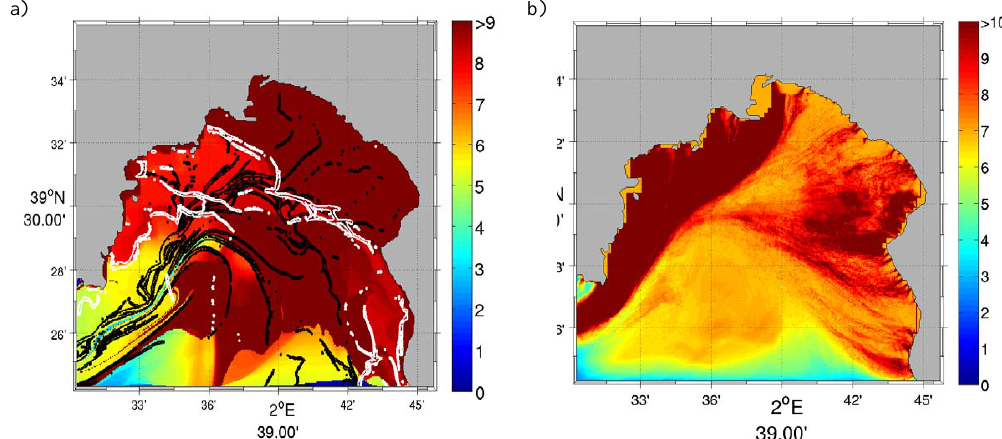
Fig. 11. (a) Snapshot of spatial distributions of residence times at the bottom layer in the Bay of Palma corresponding to 17 July 2009 at 18:00 (GMT). Lines are the locations of top values of FSLE (greater than 0 . 3day − 1 ). Backward FSLE lines are colored in black and forward FSLEs in white. (b) Spatial distribution of time average of 60 snapshots from 6-hourly maps of RT collected over 15 days in July at the bottom layer.